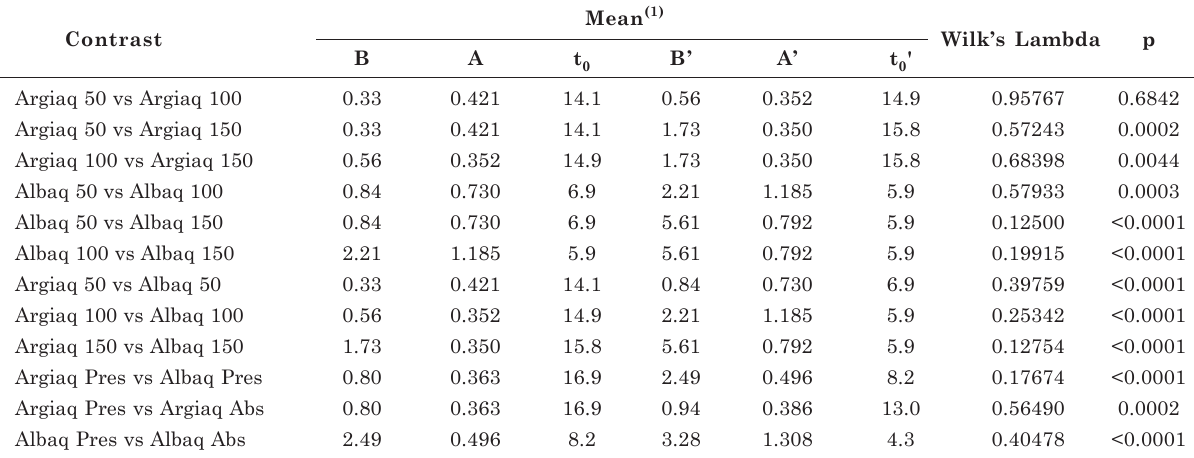
Table 5. Means of parameters, Wilk’s Lambda statistics and probability “p” of the approximate F statistic of multivariate orthogonal contrasts for the hypotheses of interest Contrast